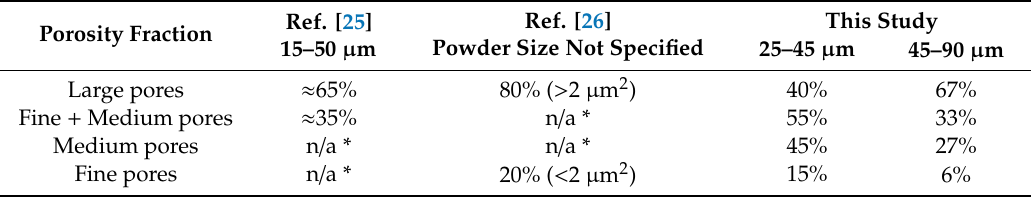
Table 2. Measurements of porosity fractions from literature compared to present work measurements for coatings prepared by medium and coarse particle size.